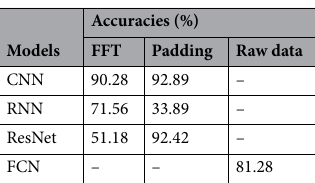
Table 6. accuracies of unsupported sleeper severity classification.